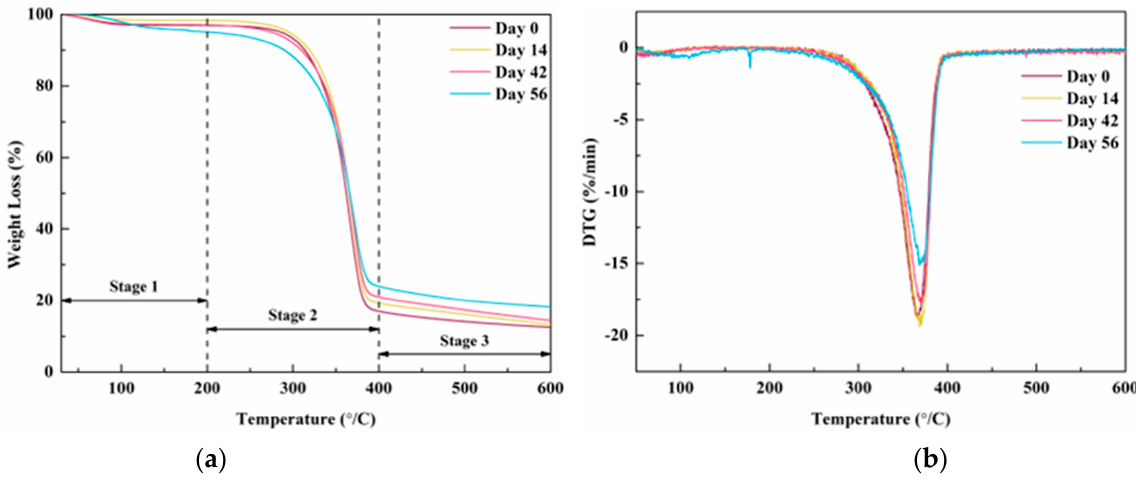
Figure 5. Thermal properties of environment-friendly bamboo fiber lunch box in different degradation stages: ( a ) TG; ( b ) DTG. stages: ( a ) TG; ( b )